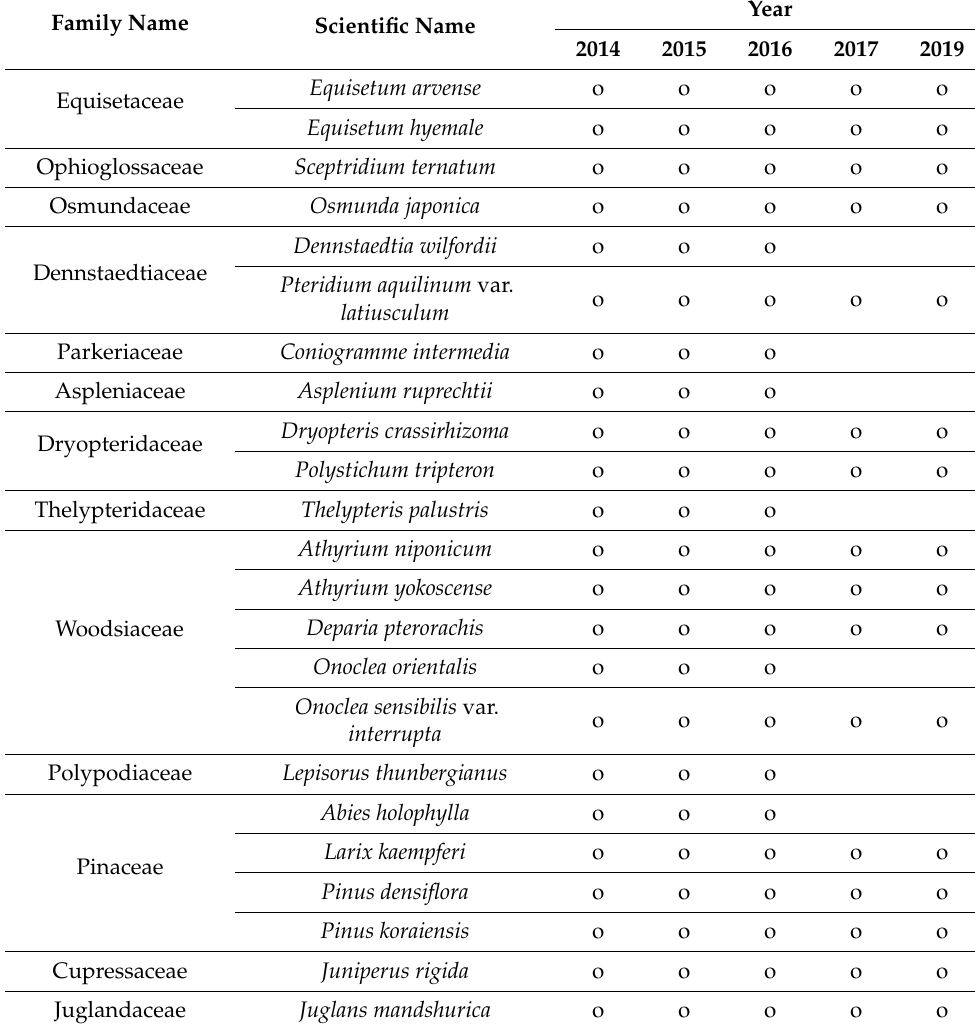
Table A1. Plants appearing from 2014 to 2019 (grazing in 2018). “o” indicates Occurrence in that year. Family